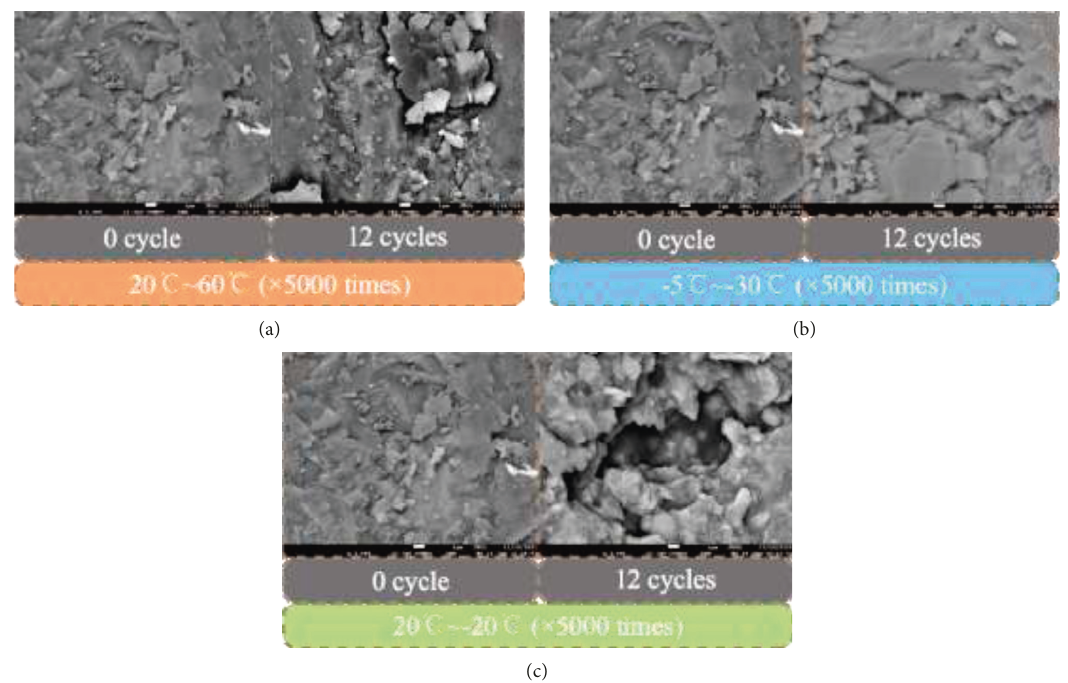
Figure 7: SEM images of specimens damaged by compression after 12 cycles at different temperature intervals. (a) 20 ° C ∼ 60 ° C ( × 5000 times). (b) − 5 ° C ∼ − 30 ° C ( × 5000 times). (c) 20 ° C ∼ − 20 ° C ( × 5000 times).